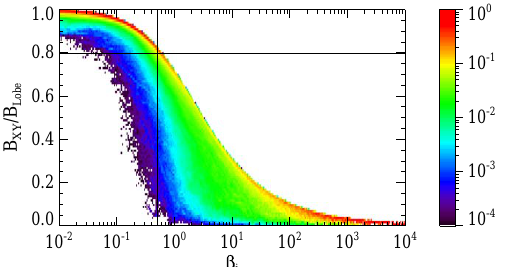
Figure 1. Data distribution at different β i values along a dis- tance relative to the neutral sheet obtained from C1 in the re- gions X < − 10 R E and | Y | < 12 R E . The steps along the x axis are log 10 (β i ) = 0.02 and along the y axis are B XY /B Lobe = 0.01. The value in each bin is determined by the number of data points in that bin divided by the total data number in the corresponding column along the y axis. Figure 2.